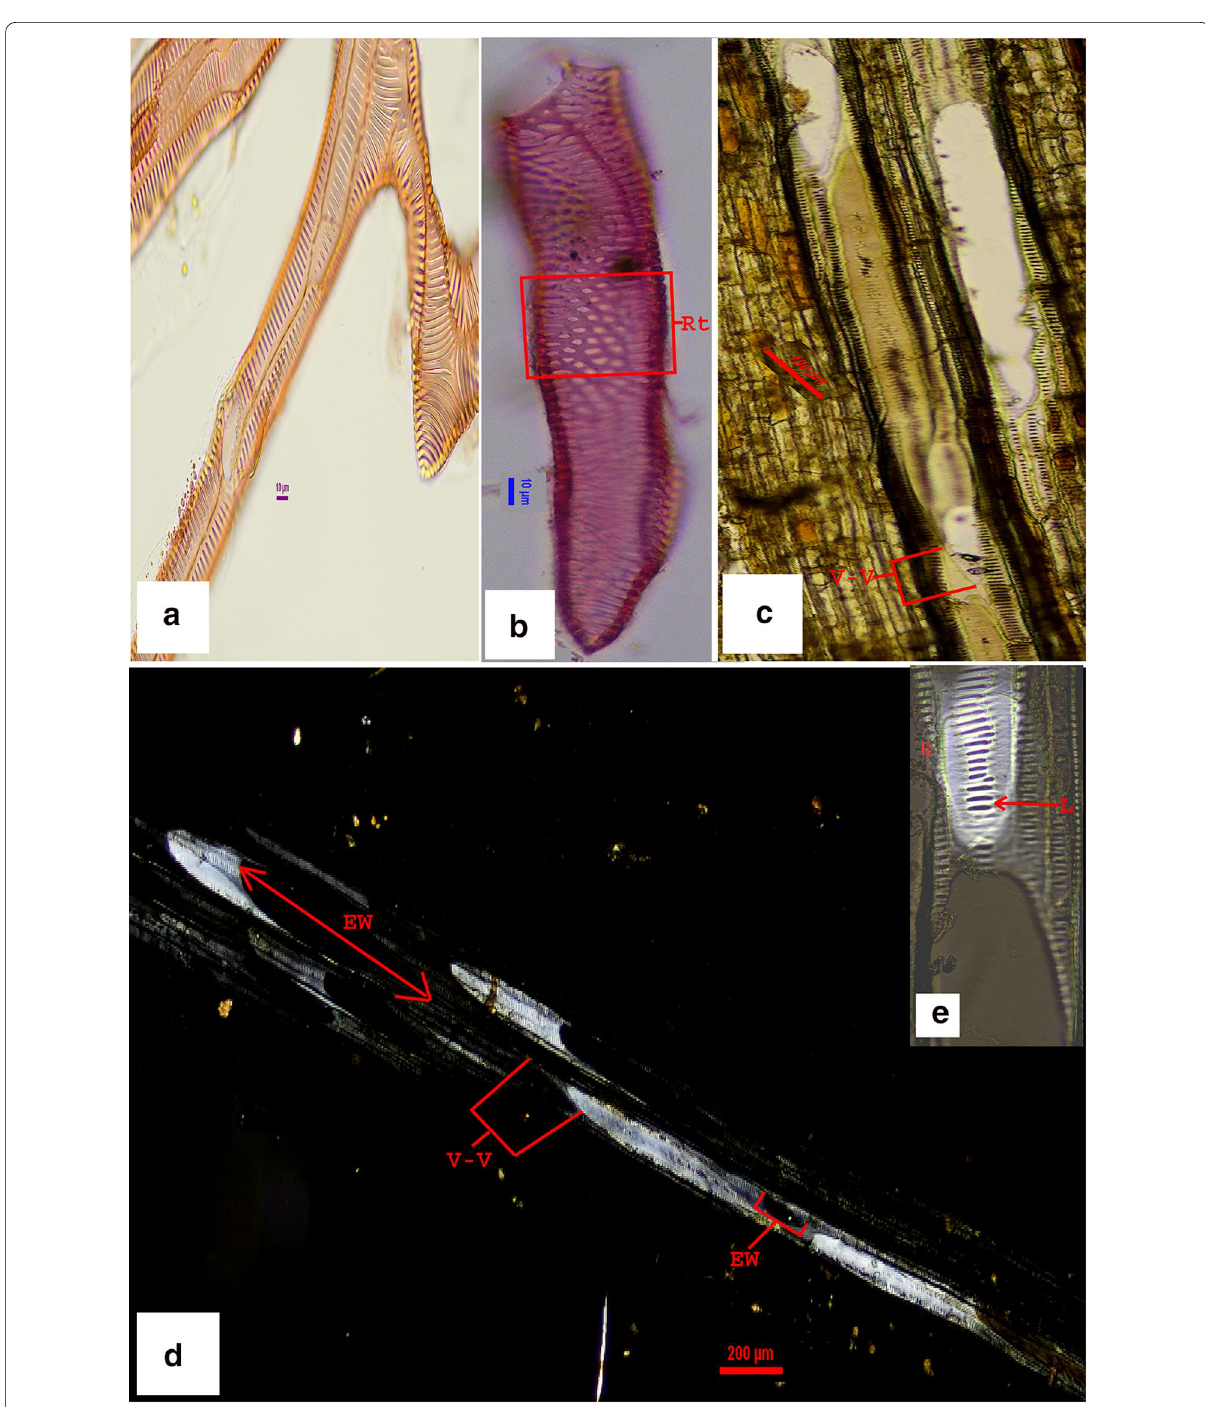
Fig. 3 b Vessel elements of costa ( Ampelopteris prolifera ) showing reticulate thickening at its lateral wall. a Branched vessel elements from macerated root–rhizome junction. c – e (petiole L.S. of Thelypteris interrupta ). c Vessel–vessel connection of unstained section. d Vessel element– vessel element connection in polarized light. e Enlarged view of single vessel member—lignified wall glittering in polarized light and the endwall portion empty (blacken part) due to the absence of lignified tissue (Abbreviations used: Rt reticulate thickening, EW endwall, V–V two vessel members are joined end to